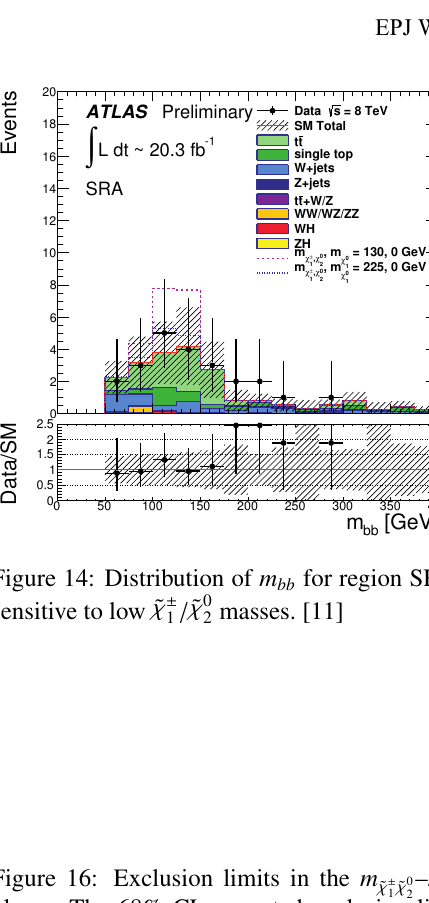
– m ˜ χ ± 1 ˜ χ 0 2 ˜ χ 0 1